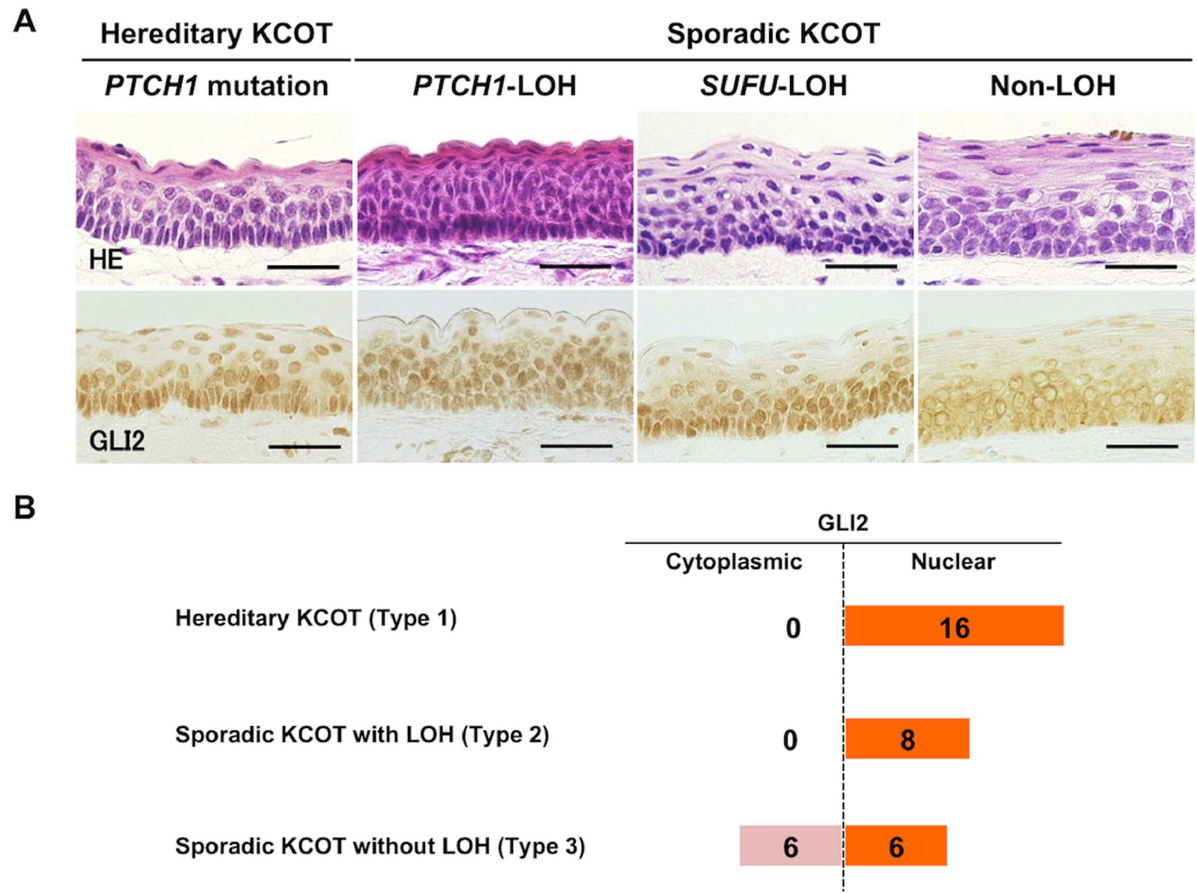
Figure 2. Immunohistochemical expression of GLI2 in KCOT. A) In hereditary KCOT and sporadic KCOT with LOH, GLI2 was detected in the nuclei, whereas it was detected mainly in the cytoplasm in about a half of sporadic KCOT without LOH. Scale bars=30 m m B) Schematic table of the GLI2 expression patterns in each subgroup. Number of cases with the designated expression patterns are depicted (see also Table 1). (Figure S2). Immunohistological examination using the GLI1 antibody yielded either no staining or insignificant staining even in control tissues, which we concluded was a weak non-specific reaction (our unpublished observation).